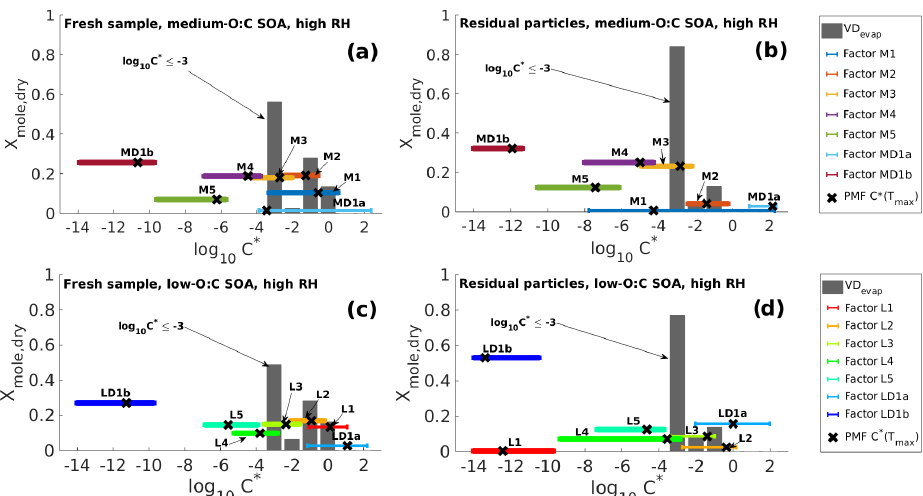
Figure 2. Volatility distributions in high-RH experiments determined from model fitting (VD evap ) and PMF analysis of FIGAERO–CIMS data (VD PMF ) for the same four cases as shown in Fig. 1. (a) Fresh sample of medium-O : C SOA. (b) Residual particles of medium-O : C SOA (the RTC sample). (c) Fresh sample of low-O : C SOA. (d) Residual particles of low-O : C SOA (the RTC sample). VD evap is shown for the best-fit simulation (gray bars) at the mean evaporation time of the FIGAERO–CIMS sample. Black crosses show the log 10 (C ∗ ) calculated for each PMF factor from the peak desorption temperature T max . The horizontal colored lines show the range of log 10 (C ∗ ) calculated from the 25th and 75th percentiles of each PMF factor’s mass loading